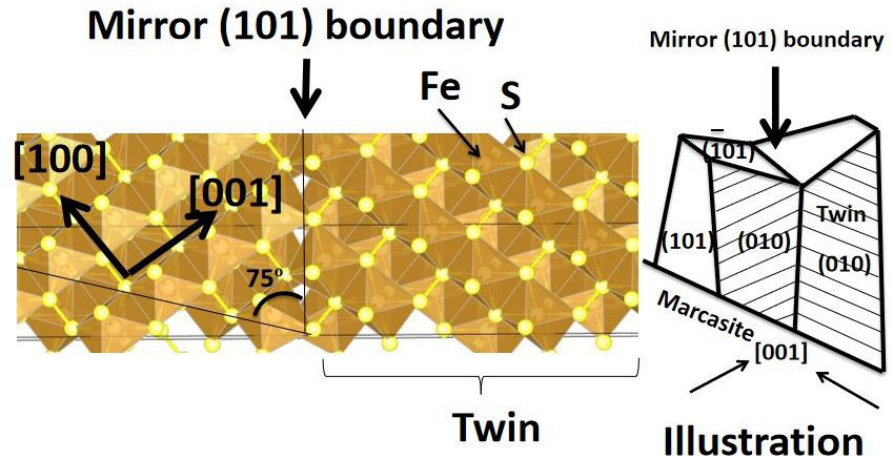
Figure 4. Structure of the optimized (101) twin mirror boundary with force field methods and illustration of a twinned striated crystal from Belgium. Polyhedral representation (Fe: brown spheres inside polyhedra, S: yellow